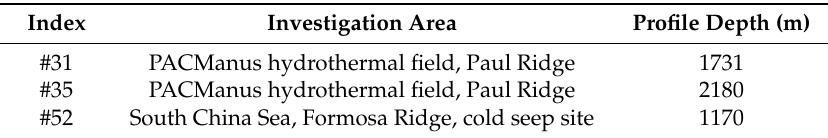
Table 1. Information of profile measurement